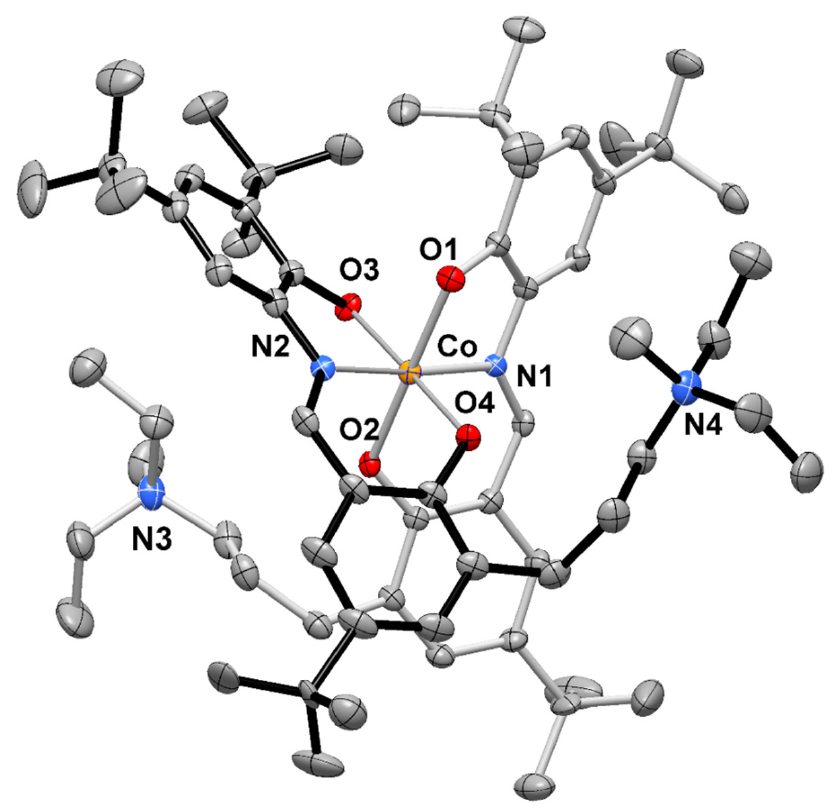
Figure 4. Molecular structure of the cationic Co(III) complex 5 . (Ortep drawing with displacement ellipsoids at 50% probability level. H atoms not shown for clarity).